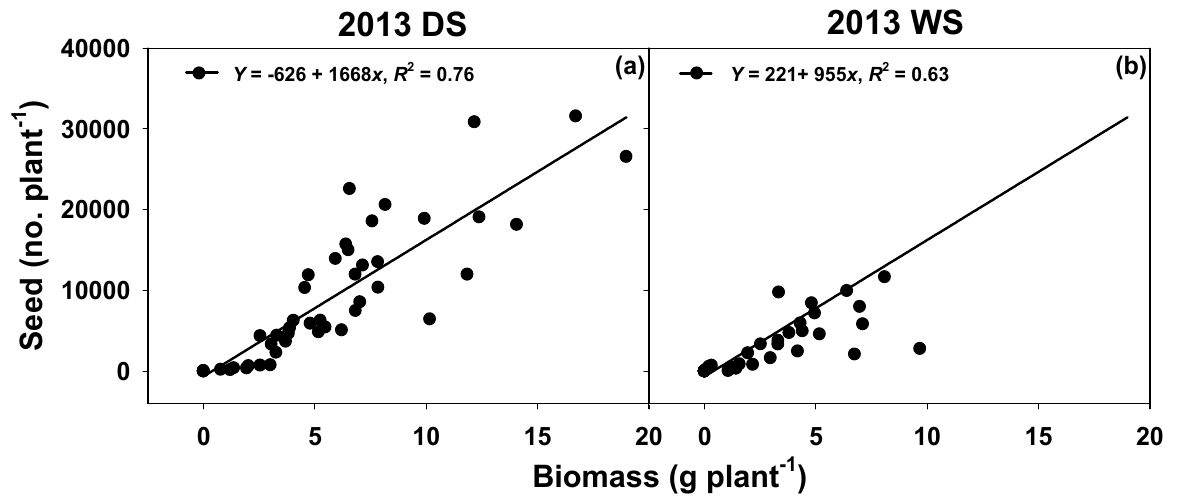
Figure 5. Association between plant biomass g plant − 1 and seed number plant − 1 for C. iria for dry and wet seasons. Data included are overall averages of C. iria planting densities of 40 and 80 plants m − 2 without and with rice.